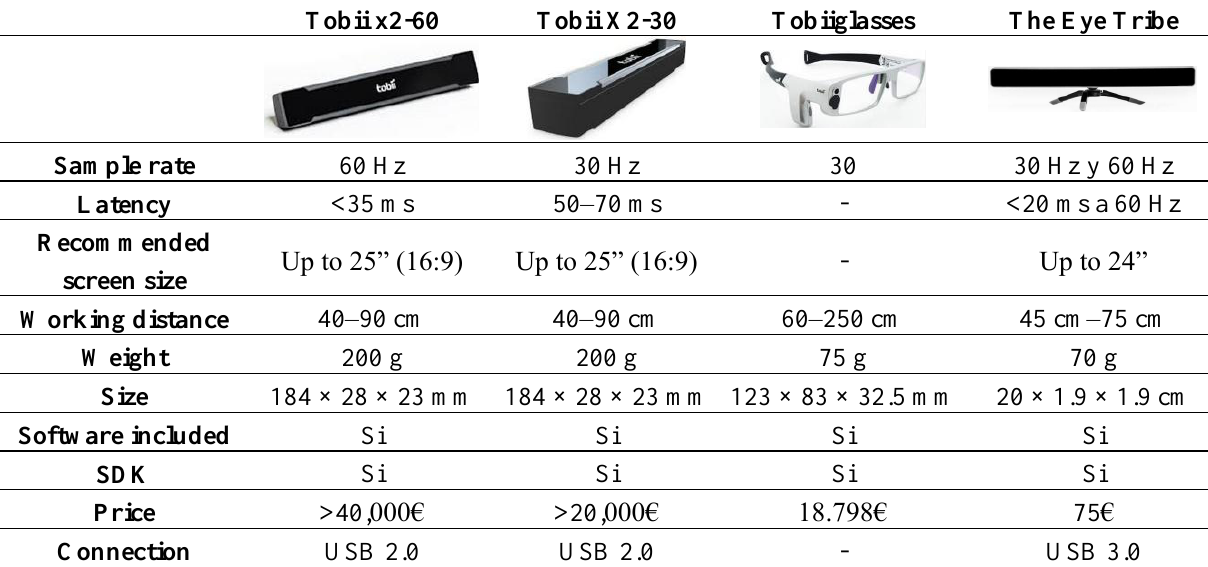
Table 1. Comparison of commercial eye